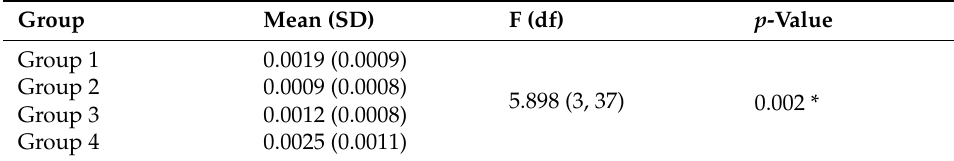
Table 5. Comparative evaluation of water sorption of all groups.